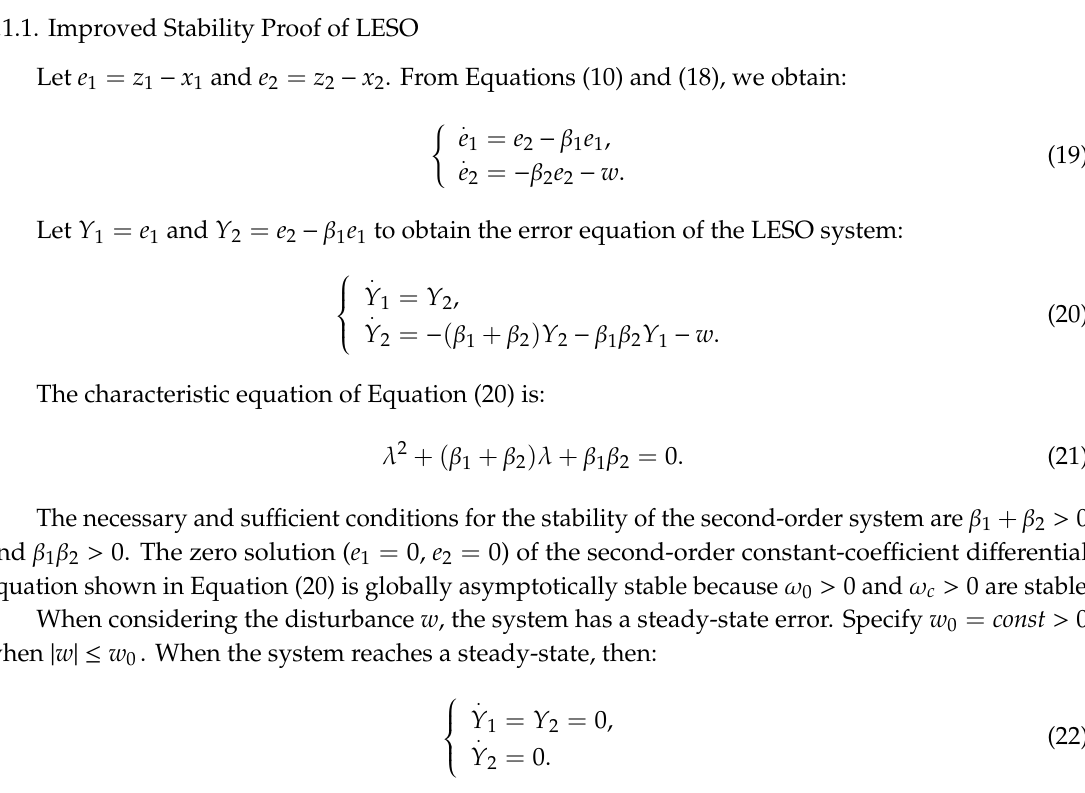
Figure 6. Structure of the improved controller.